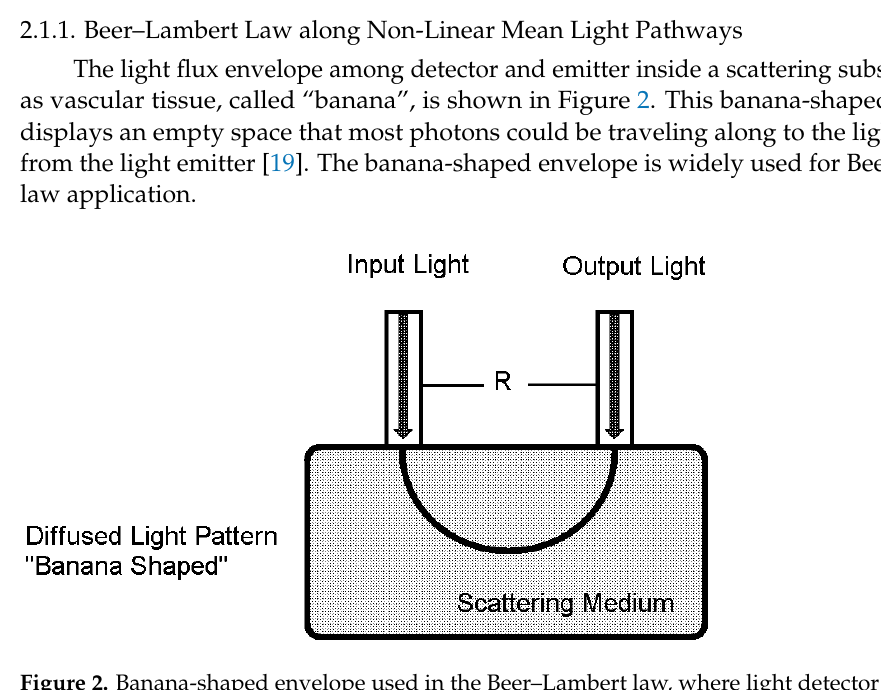
Figure 1. Relationship between the attenuation of light through a substance and the properties of that substance.